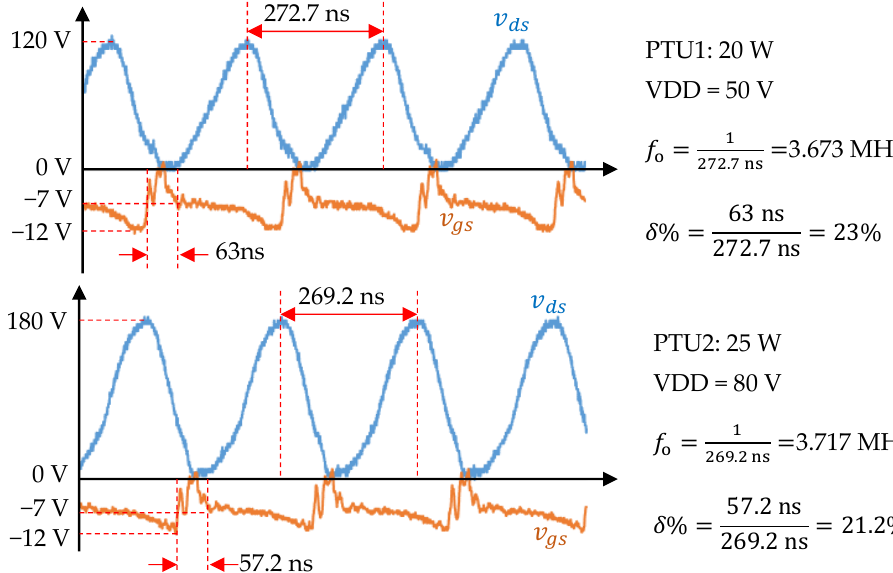
Figure 24. The wave form of the input signal v GS and output signal v DS of class-E Amplifier. Table 5. Control voltage inputs of the individual PTUs in Figure 23. Corresponding Unit Control Voltage